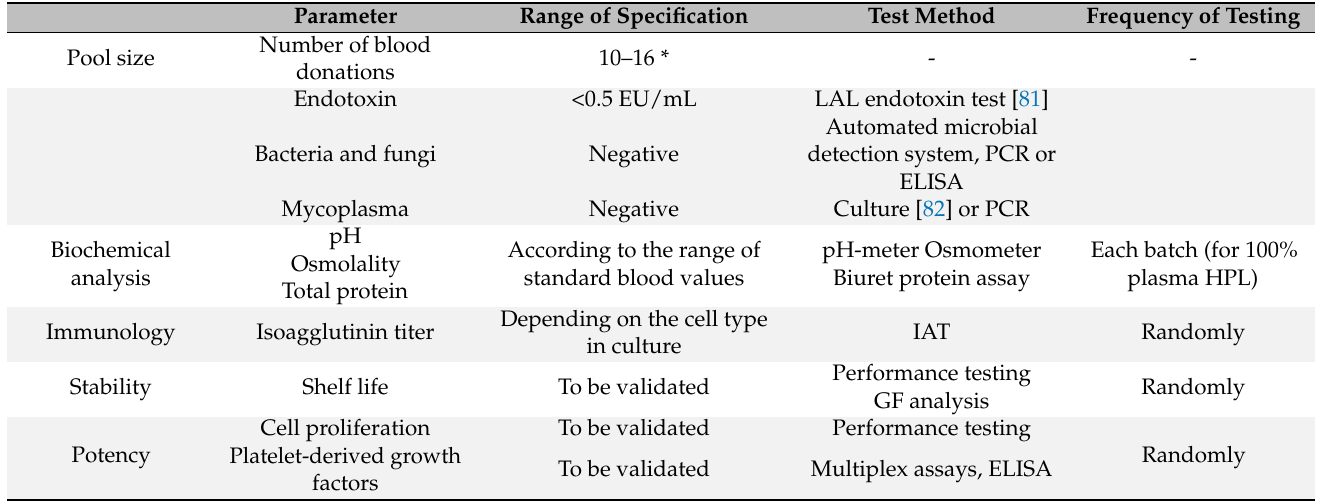
Table 2. Quality specifications of pooled human platelet lysate (HPL) recommended in accordance to [72], modified from [21]; * without further pathogen reduction procedure. Abbreviations: EU, endotoxin unit (according to [81]); LAL, limulus amebocyte lysate; PCR, polymerase chain reaction; IAT, indirect antiglobulin test; ELISA, enzyme-linked immunosorbent assay; GF, growth